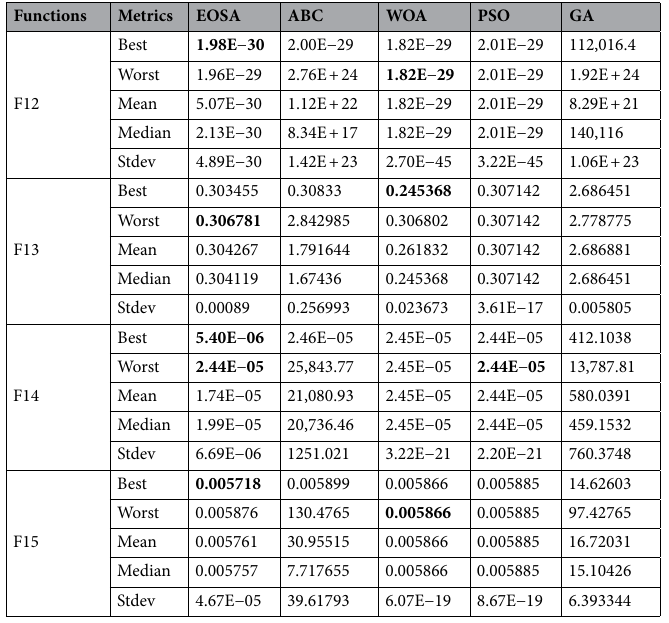
Table 7. Comparison of best, worst, mean, median and standard deviation (stdev) values for EOSA, ABC, WOA, PSO, and GA metaheuristic algorithms using the classical benchmark and IEEE CEC functions over 500 epochs and 100 population